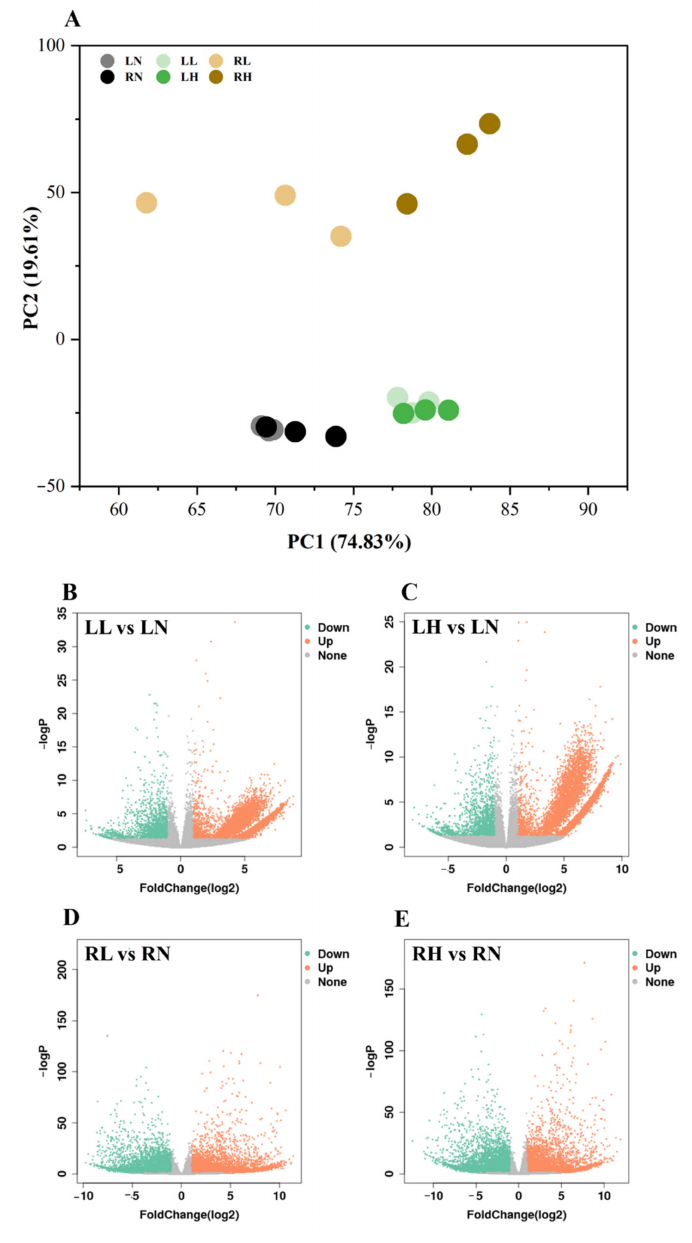
Figure 2. Principal component analysis (PCA) of the gene expression at different concentrations of phosphorus ( A ), and volcano plots of the differentially expressed genes (DEGs) between control and treated Myriophyllum aquaticum ( B – E ). LN, LL and LH: leaf samples from normal (0.25 mM), low (0.02 mM) and high (5 mM) phosphorus concentration treatment; RN, RL and RH: root samples from normal (0.25 mM), low (0.02 mM) and high (5 mM) phosphorus concentration